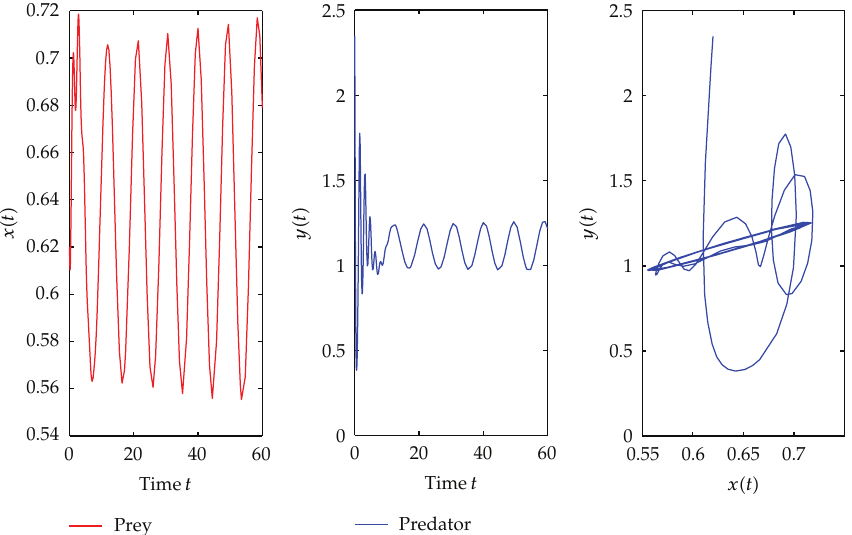
Figure 4: E ∗ is unstable for τ 1 (cid:5) 2 . 4 > τ 1 ∗ (cid:5) 2 . 3211 ,τ 2 (cid:5) 0 . 36 with initial value